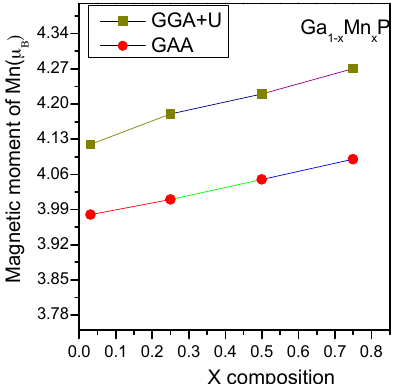
Figure 1. Atom resolved magnetic moments of Mn-doped Ga 1 − x Mn x P ( x = 0.75, 0.5, 0.25, 0.03) alloys versus the variation of composition x .